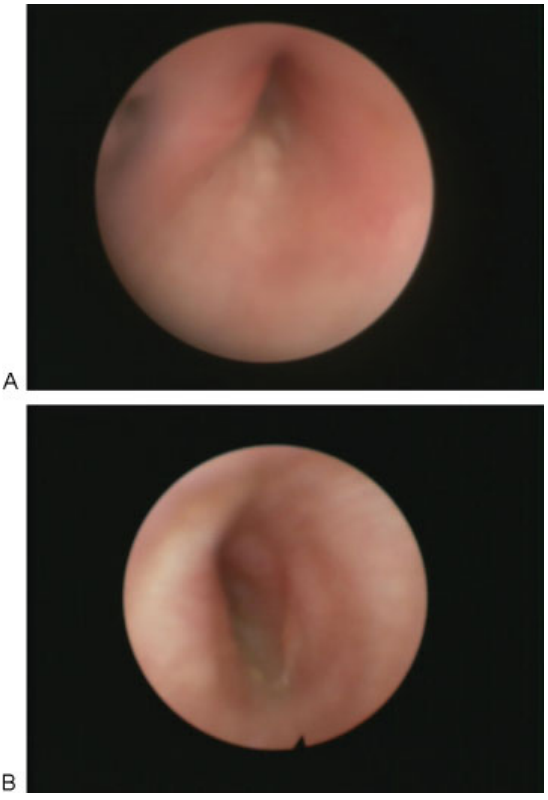
Fig. 2 Preoperative bronchoscopy showed signi fi cant, pulsatile narrowing of the lower airway, most likely due to the large adjacent pulmonary artery (PA) (A). After placing and in fl ating the tissue expander in the right chest, the narrowing seemed to have improved